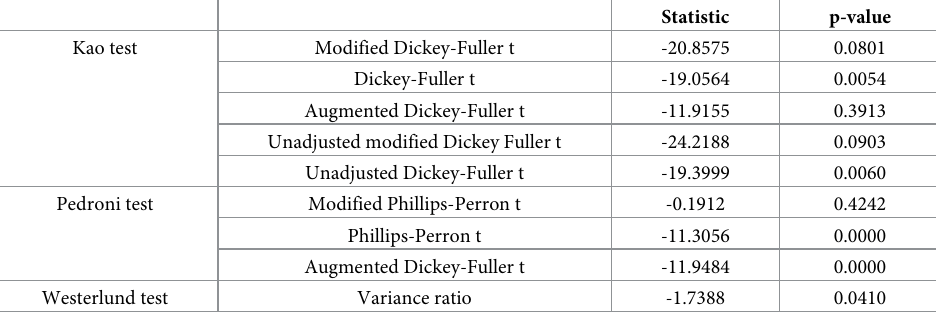
Table 20. Cointegration test of logistics industry and the efficiency of two-industry-linkage.